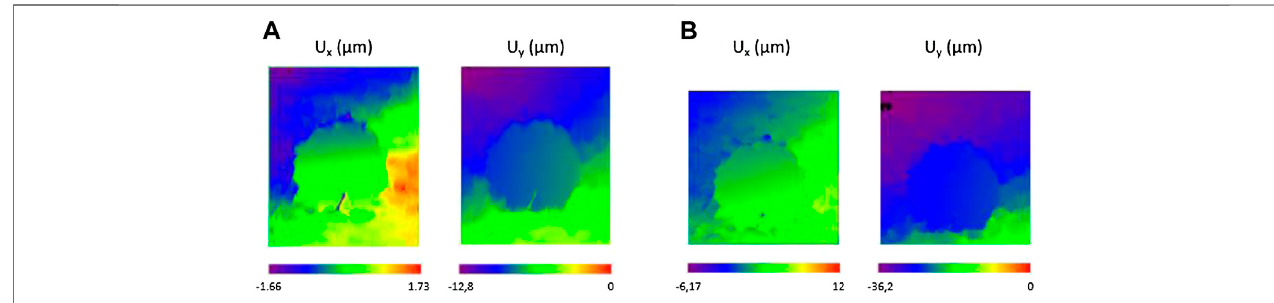
FIGURE4| Examplesofdisplacement fi eldsforasamplewithoutaballoonat (A) 0.66 mmand (B) 1.33 mmofimposeddisplacement(loadingspeed:1 mm/min).